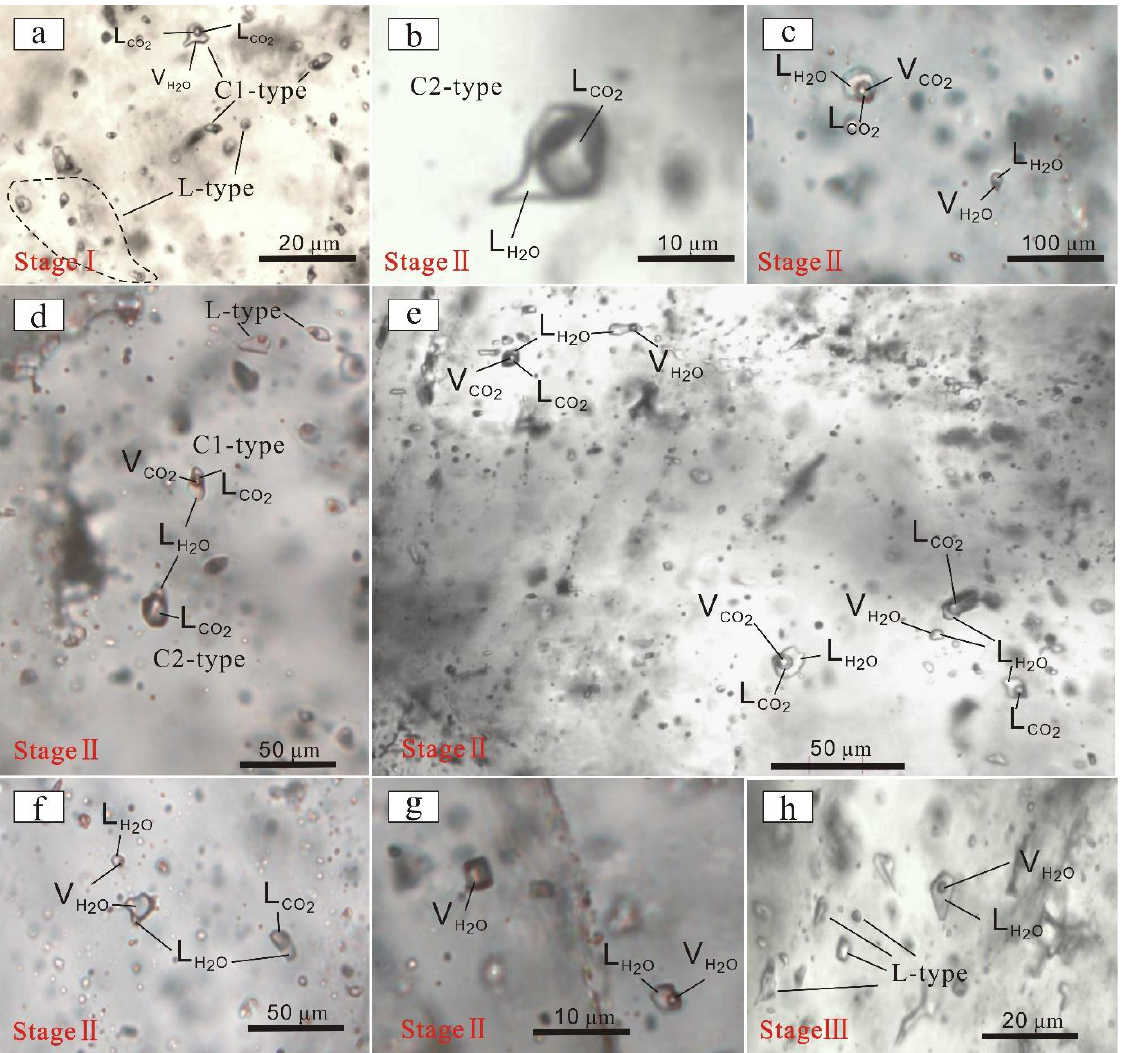
Figure 5. Photomicrographs of typical fluid inclusions in Toudaochuan deposit: ( a ) C1-type FIs coexisted with L-type FIs in stage I quartz; ( b ) C2-type FIs as two phases (liquid water + liquid CO 2 ) at room temperature in stage II quartz; ( c ) C1-type FIs coexisted with L-type FIs in stage II quartz; ( d , e ) L-type, C1-type, and C2-type FIs coexisted in stage II quartz; ( f ) L-type, V-type, and C2-type FIs coexisted in stage II quartz; ( g ) L-type and V-type FIs coexisted in stage II quartz; ( h ) L-type FIs assemblage in stage III quartz.